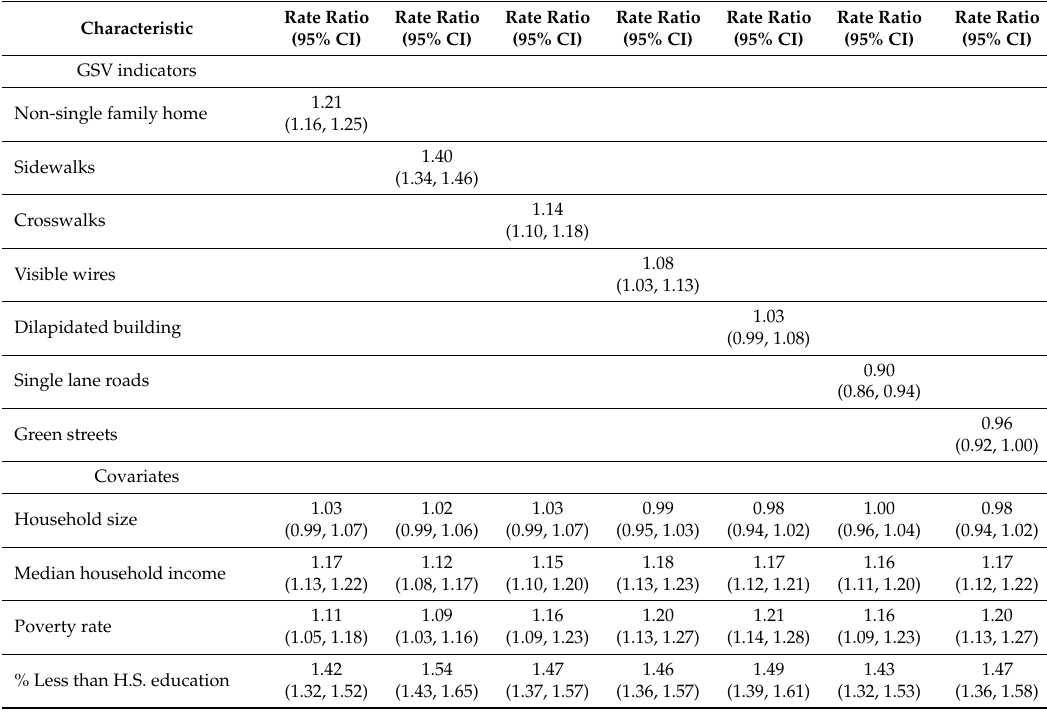
Table 2. Associations between built environment characteristics and zip code level coronavirus cases, 20